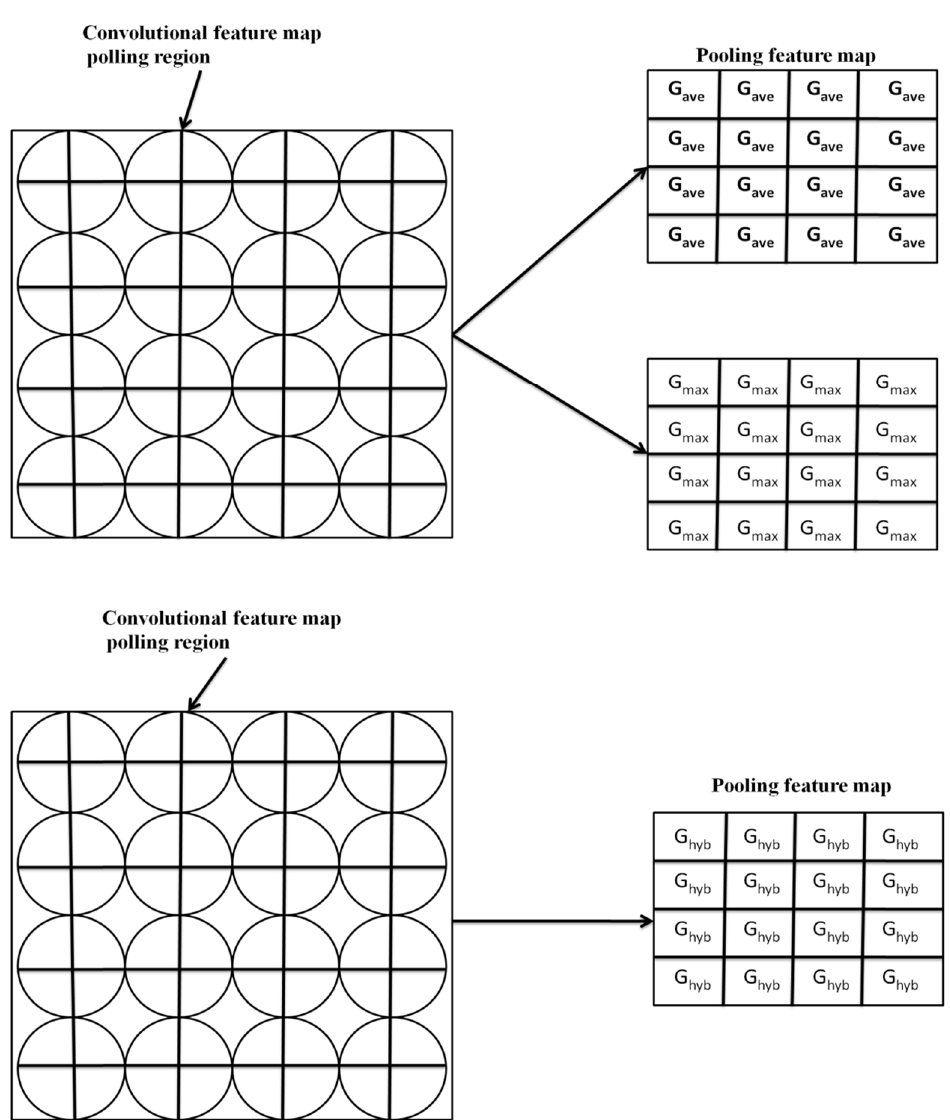
Figure 3. Convolutional hybrid maxpooling.